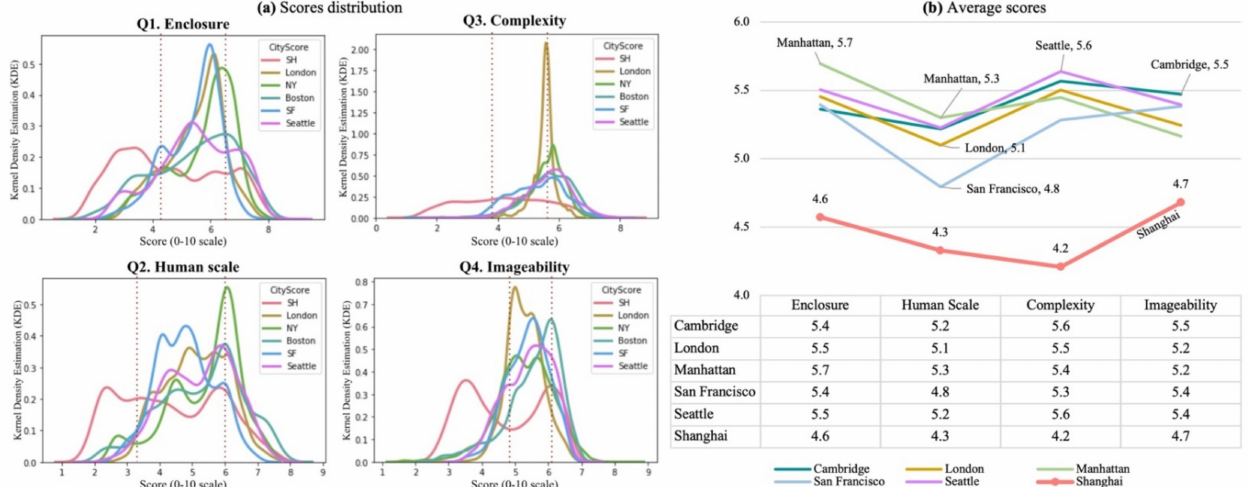
Figure 8. Comparing the perceptual qualities of six cities. ( a ) Score distributions. ( b ) Averaged